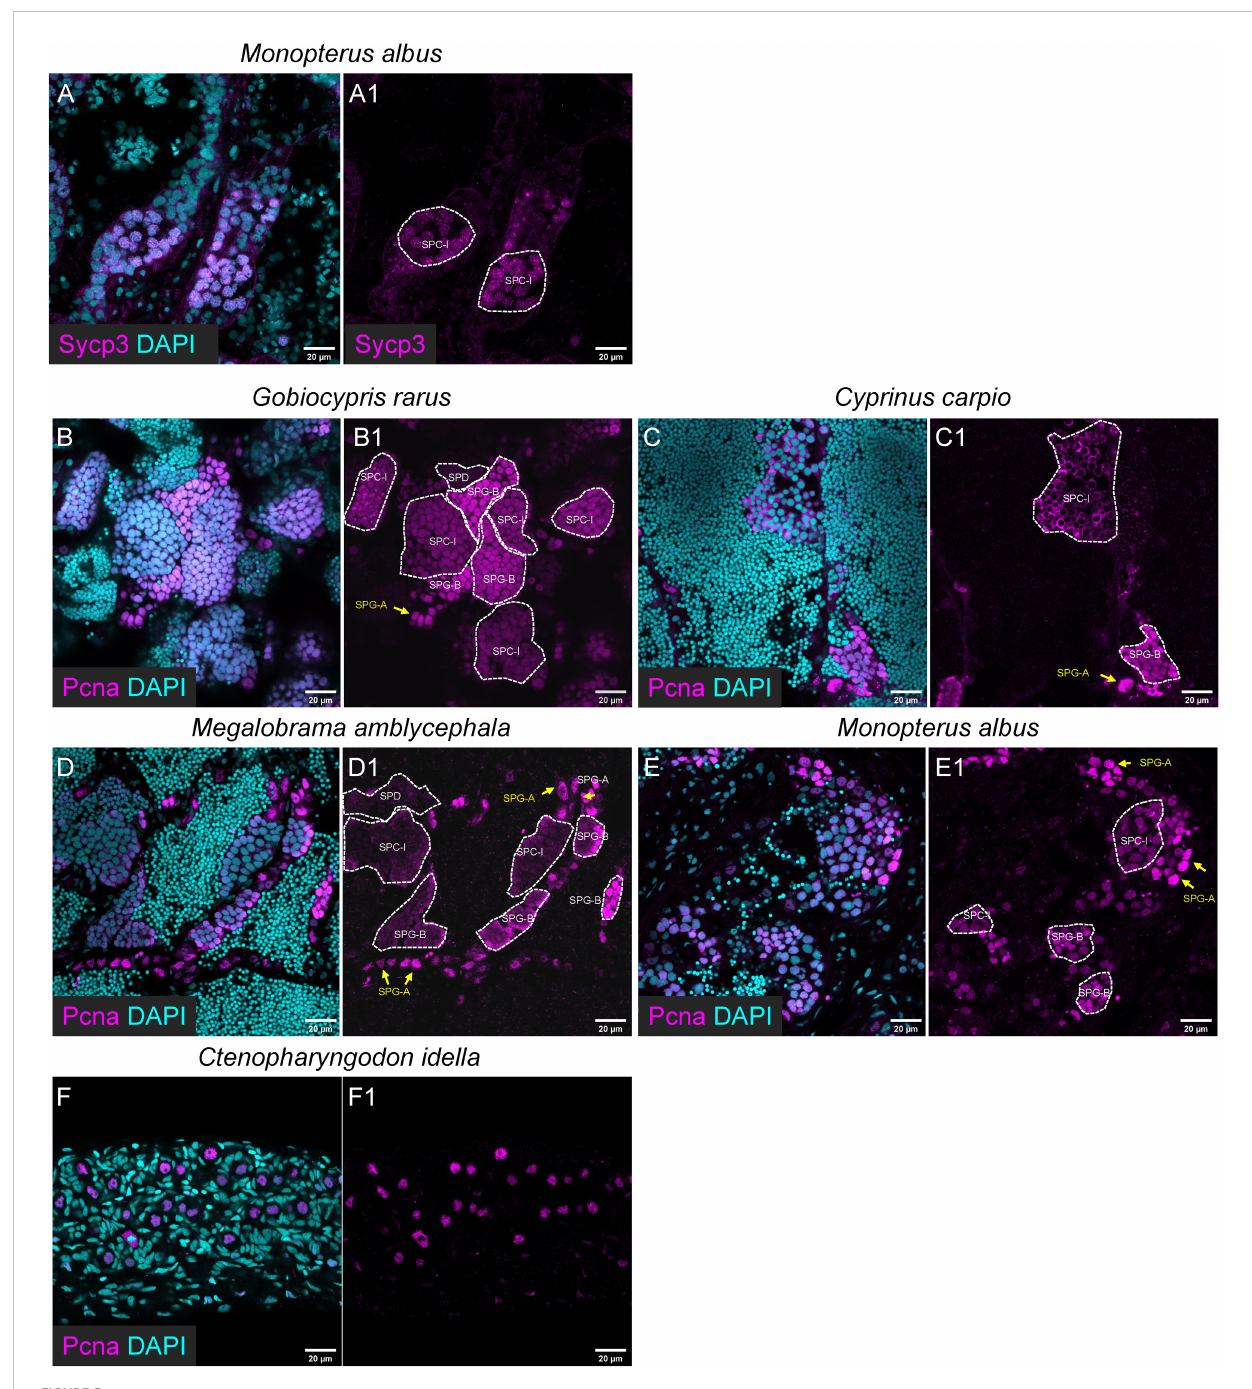
(B, B1) , Cyprinus carpio (C, C1) , Megalobrama amblycephala (D, D1) , Monopterus albus (E, E1) and Ctenopharyngodon idella (F, F1) . SPG-As are indicated by the arrows, and other types of spermatogenic cells are circled by dashed